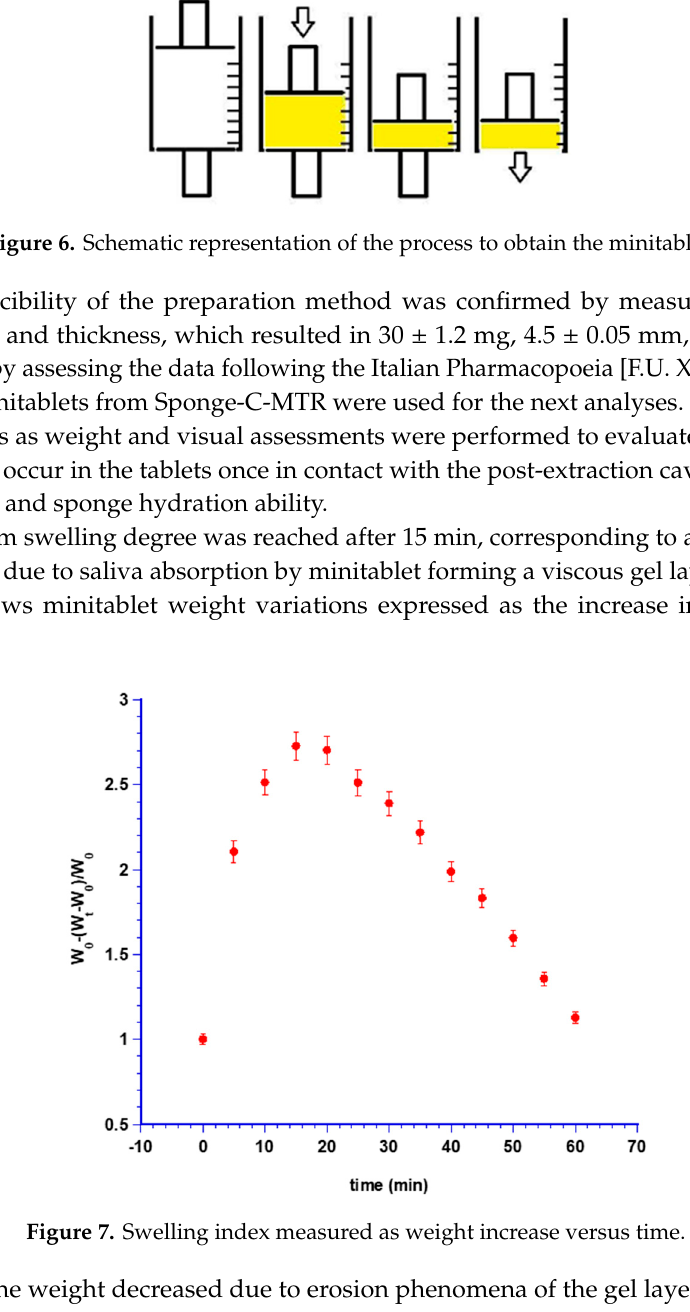
Figure 8. Timeline from 0 to 120 min of radial and frontal swelling of the minitablet. The minitablets’ ability to release the drugs entrapped respectively in the NLC and in the dried matrix network was evaluated by performing the releasing tests in strict accordance with the different aptitudes and characteristics of compounds. Thus, isopropyl myristate or citrate buffer enriched in 4% (w/v) Polisorbate20 were chosen as acceptor fluids to observe the CUR or the MTR release individually, since there is not a common medium in which both drugs are soluble. The results of release experiments, expressed as dose fraction released versus time (Figure 9), suggest that several physicochemical phenomena are involved in the release mechanisms of the drugs. In CUR release, a